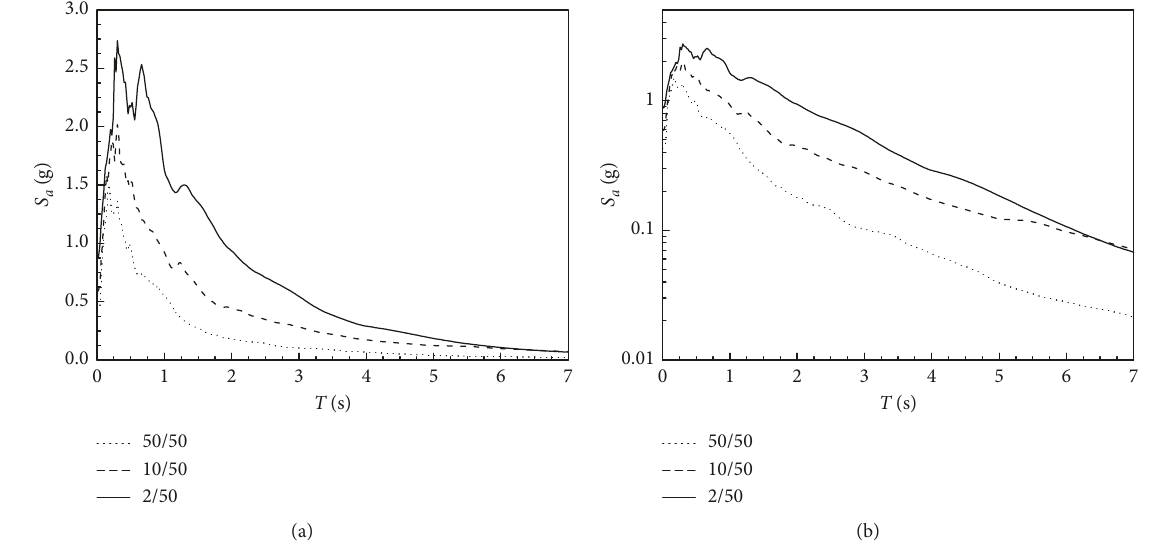
Figure 1: Target spectra plotted on (a) arithmetic and (b) logarithmic scales, 50/50, 10/50, and 2/50 sets